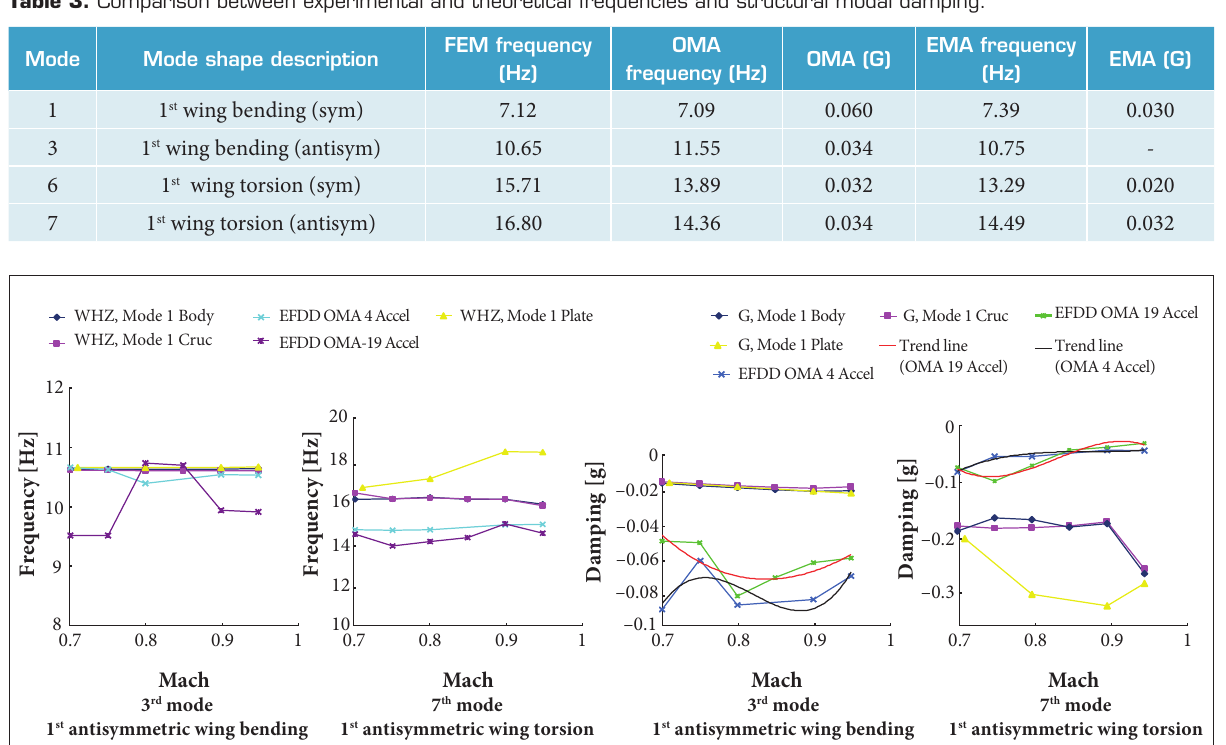
table 3. Comparison between experimental and theoretical frequencies and structural modal damping.